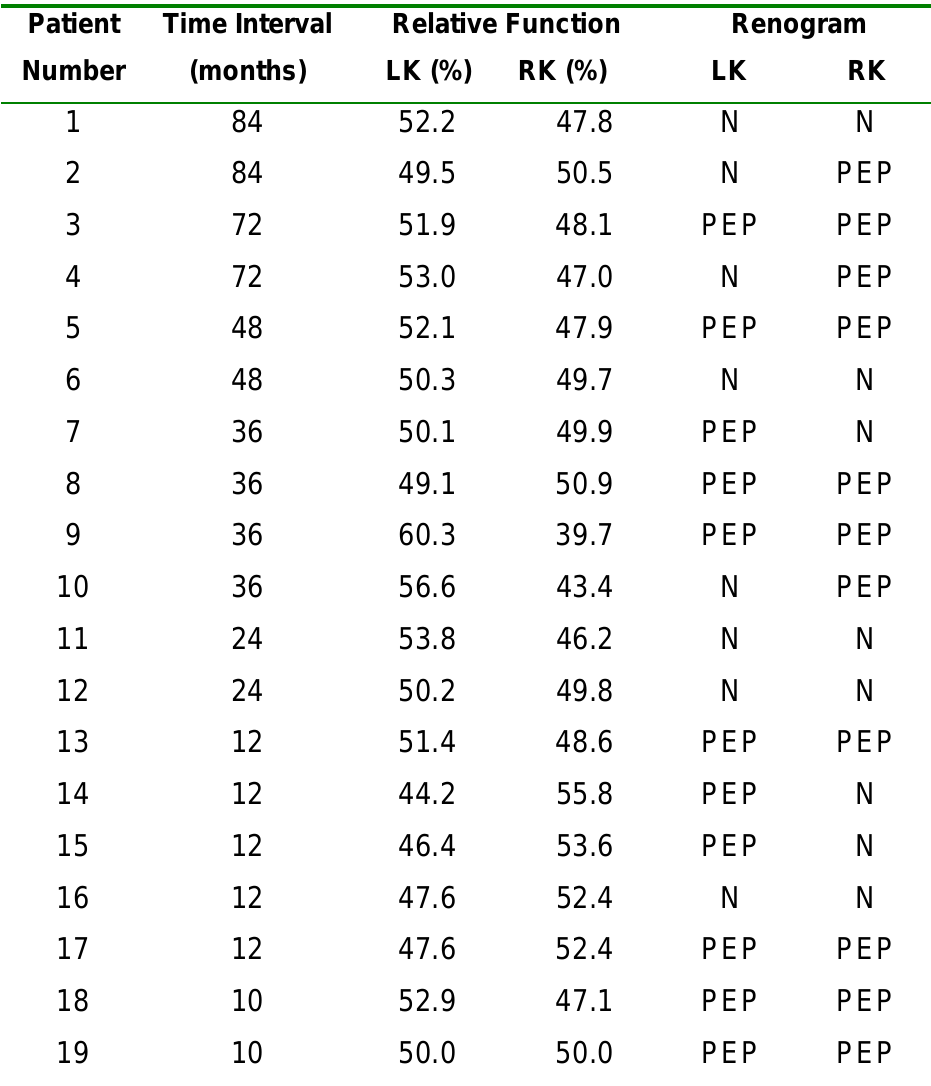
Table 2. Time interval between exposition to the parasite and initial symptoms and/or signs; renal relative function; and the renogram results.